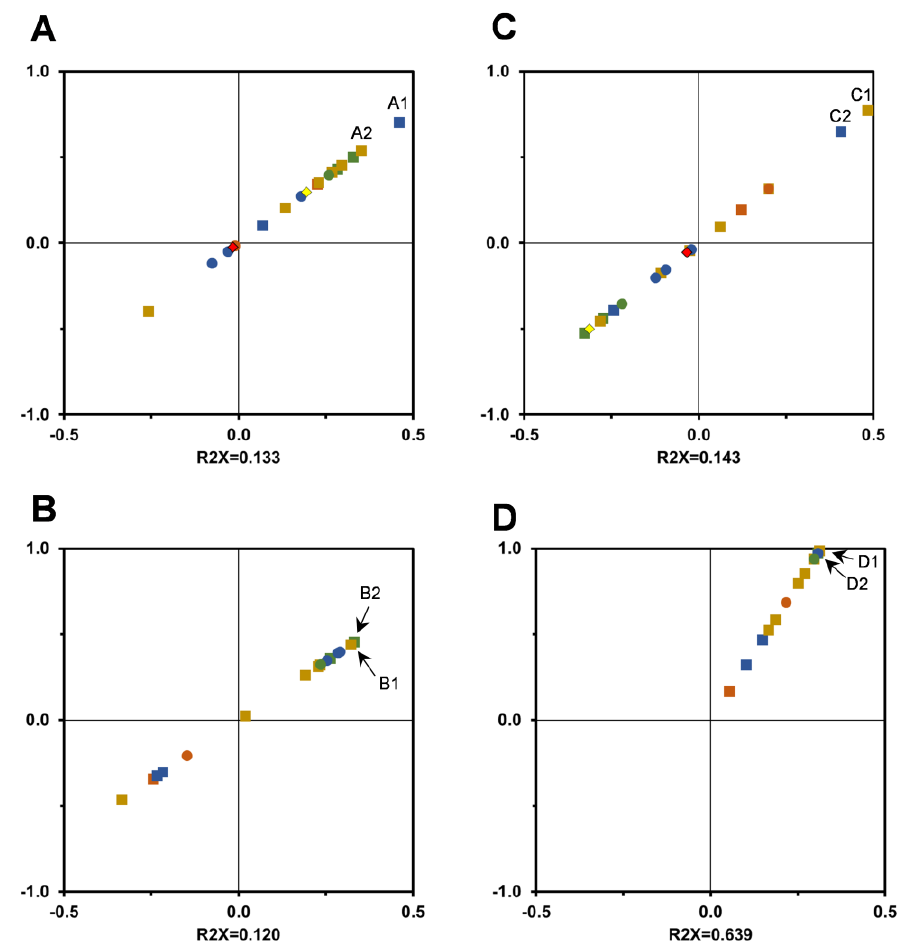
Figure 8. Correlation between individual phytochemicals and Anti-AChE (( A ): HE extract; ( B ): AD extract) and α -glucosidase (( C ): HE extract; ( D ): AD extract), by T. carnosus extracts presented as score-plots obtained by OPLS-DA model analysis. Caffeic acid —● , rosmarinic acid —●, salvianolic